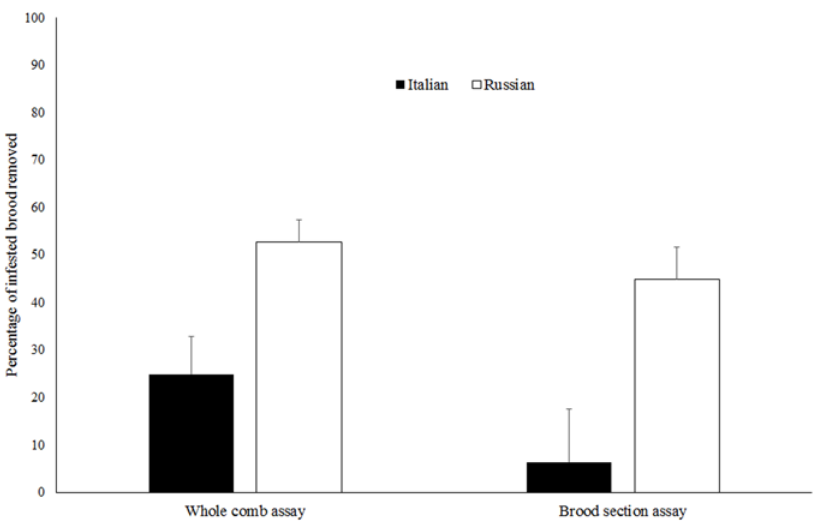
Fig 2. A comparison of the percentages of Varroa -infested brood removed by Italian and Russian honey bees using the whole comb and brood section assays. Percentage of Varroa -infested brood removed was calculated as the % change in Varroa infestation of donor